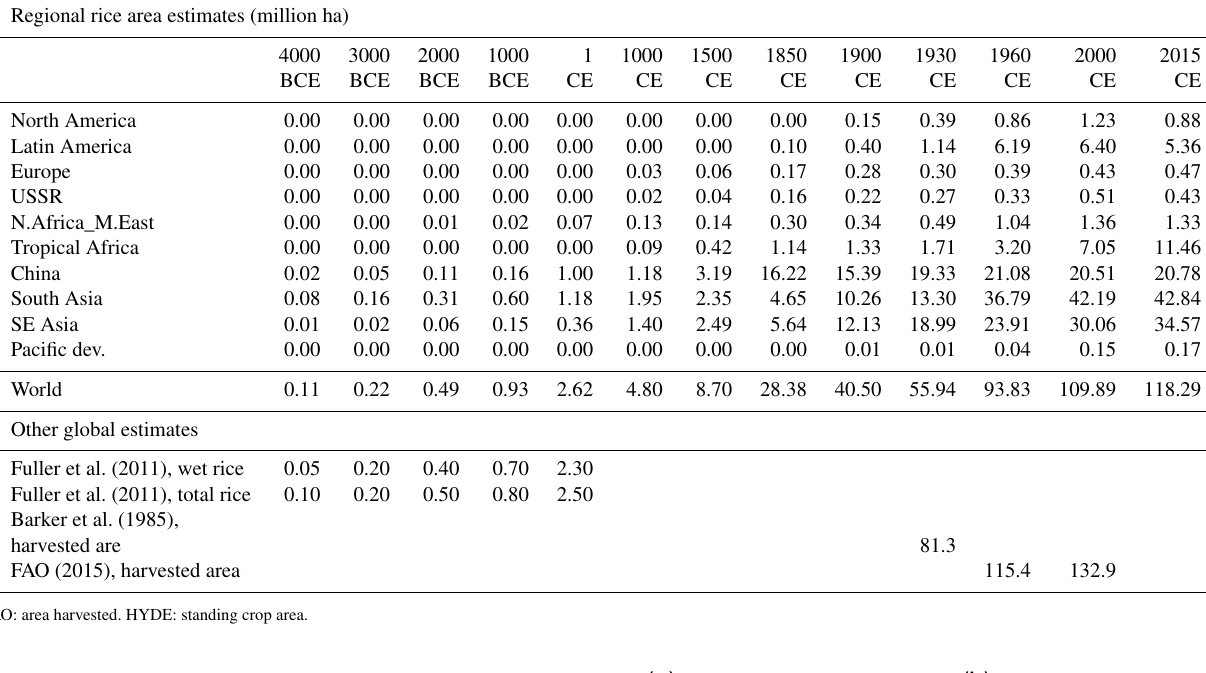
Table 4. Regional rice area estimates (million ha).